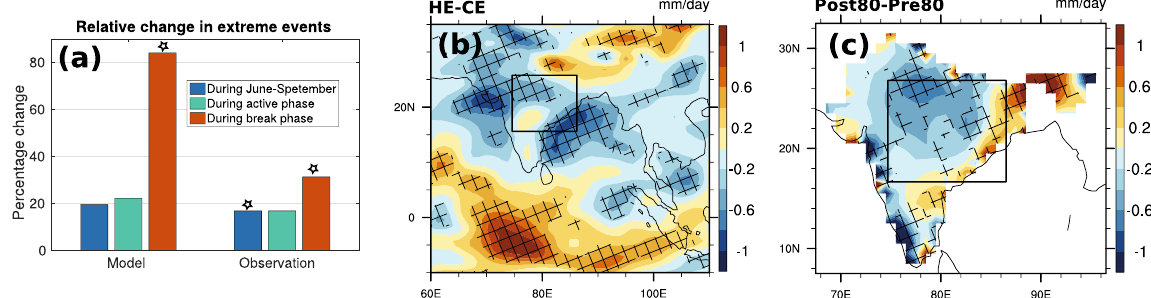
Figure 1. Changes in extreme events and daily climatology during JJAS. ( a ) Relative changes in the occurrences of extreme events over CI in model and observations during monsoon season, and active and break phases. Change in daily climatology in ( b ) Model (HE–CE) and ( c ) Observations (post80–pre80), during JJAS months. Units are in mm / day . Asterisks in ( a ) and hatched regions in ( b ) and ( c ) indicate places where the changes are significant at 10% level (using t-test). Rectangles in ( b ) and ( c ) mark the central Indian (CI) region (16.5°N to 26.5°N, 74.5°E to 86.5°E). Figure ( a ) is generated using MATLAB R2015a (https://in.mathworks.com/products/ new_products/release2015a.html). Figures ( b ) and ( c ) are generated using NCAR Command Language 6.3.0